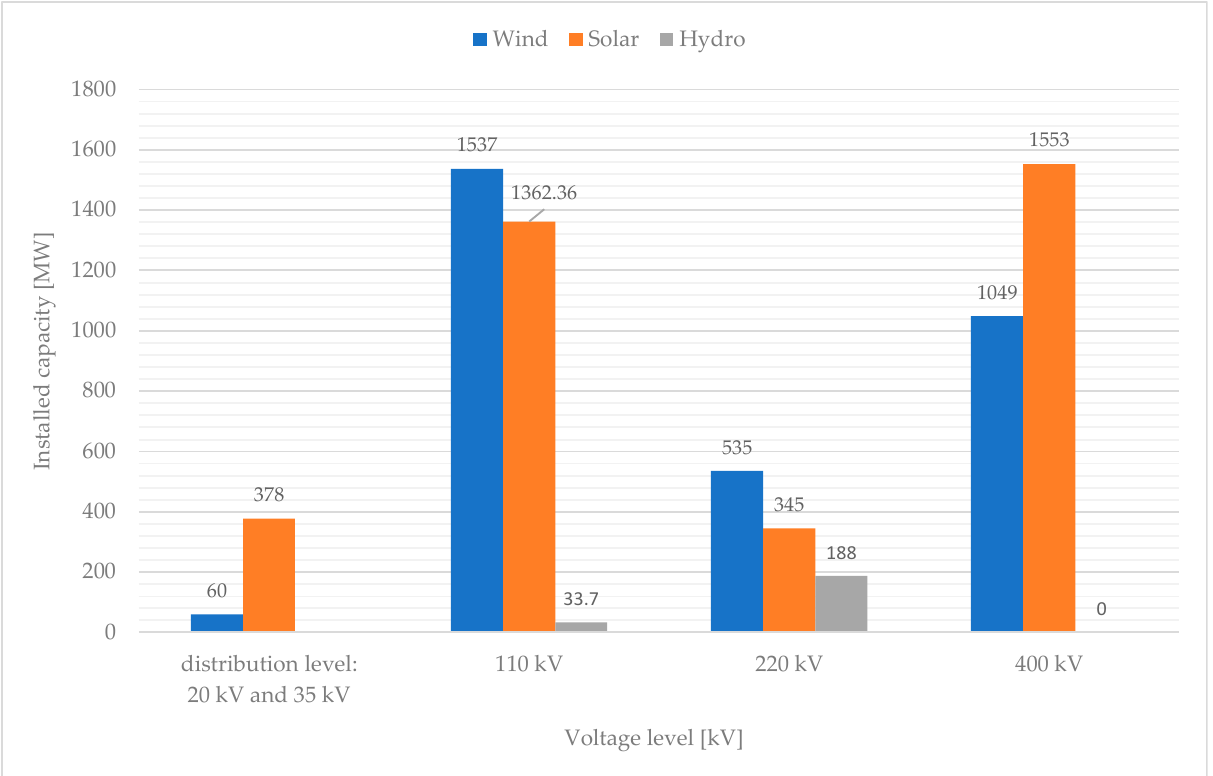
Figure 5. Total planned RES capacity in the period 2020–2030 divided by voltage levels.